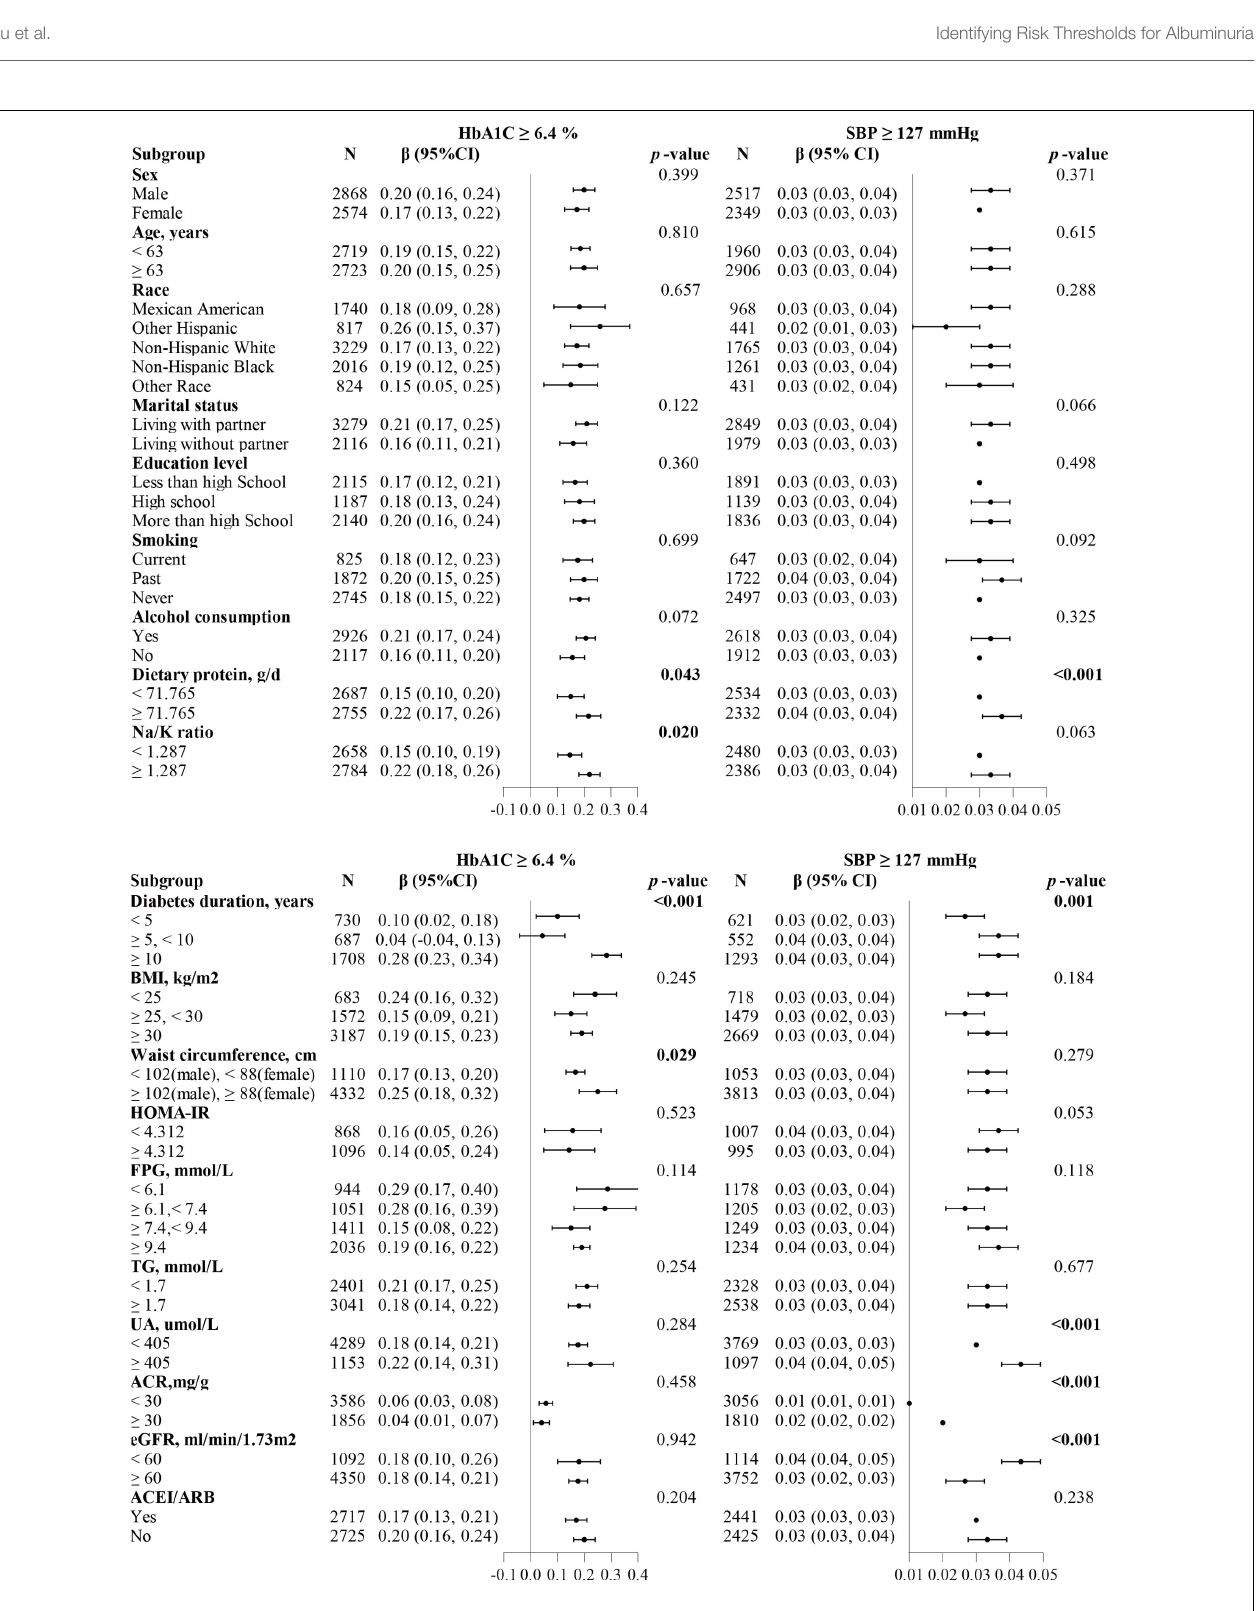
FIGURE 3 | Forest plots summarizing the subgroups analyses for ACR with HbA1c or SBP divided by thresholds (HbA1c ≥ 6.4%, SBP ≥ 127 mmHg). The dietary protein, Na/K ratio, and HOMA-IR subgroups were divided based on the median. Each subgroup analysis adjusted for age, sex, marital status, education level, smoking, alcohol consumption, diabetes duration, body mass index (continuous), waist circumference (continuous), fasting plasma glucose, glycated hemoglobin/systolic blood pressure, diastolic blood pressure, triglyceride, uric acid, estimated glomerular filtration rate and dietary protein, except the subgrouping